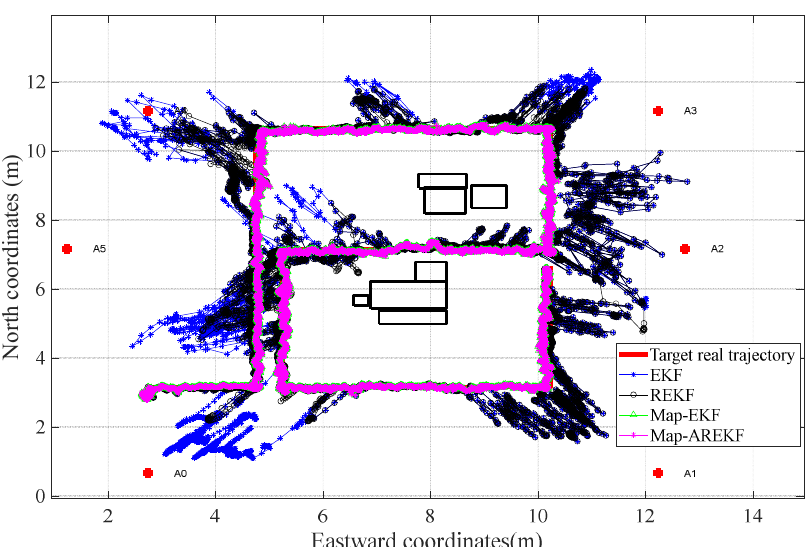
Figure 23. Experiment 3 results of 4 localization algorithms solved when using 0.5 m interval information maps.